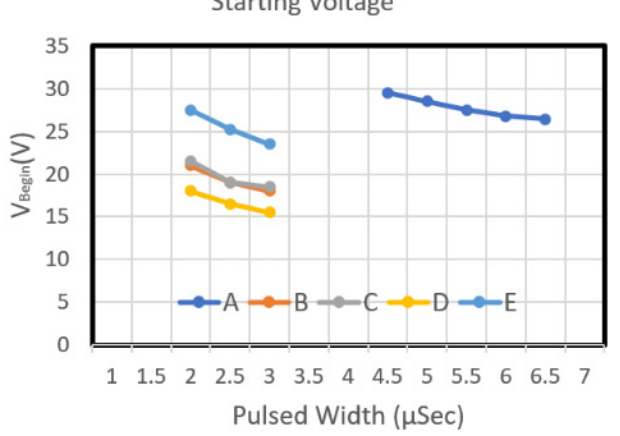
Figure 8. The initial voltage diagrams of chip number A,B,C,D,E type.